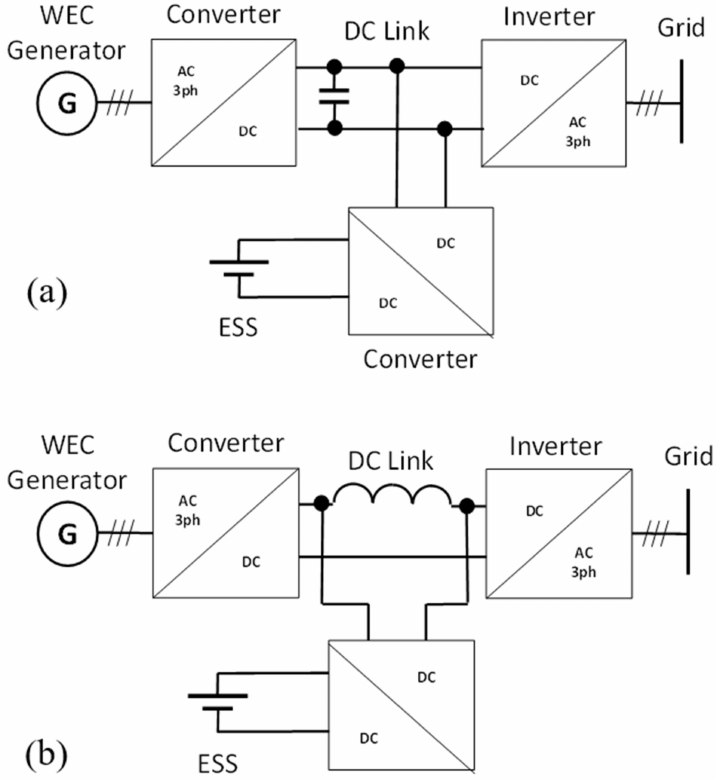
Figure 8. A single drive train unit including ( a ) voltage source and ( b ) current source